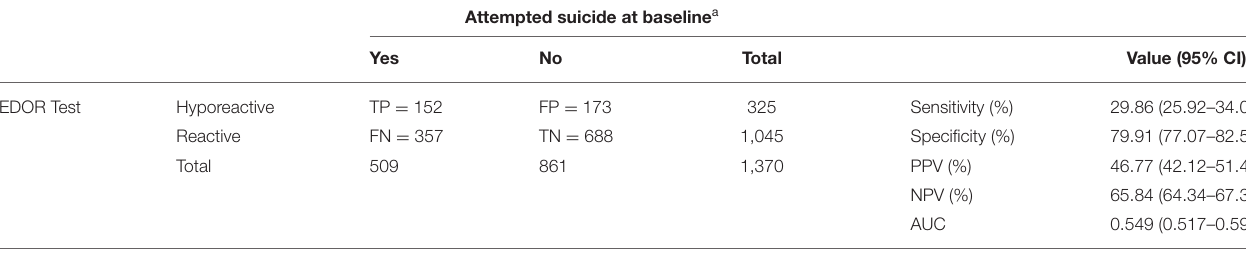
TABLE 3 | Sensitivity, specificity, and AUC of ElectroDermal Orienting Reactivity (EDOR) test and suicide attempt at baseline.